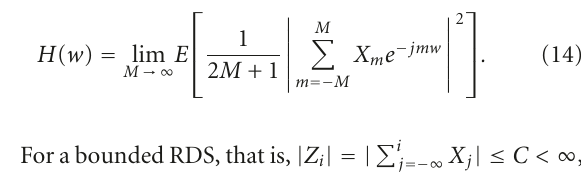
sequences X corresponding to 132 ≤ β ≤ 387 in the enumerating algorithm), and the substitute table with 131 codewords (i.e., sequences X corresponding to 1 ≤ β ≤ 131) is used to minimize the power spectral density at low